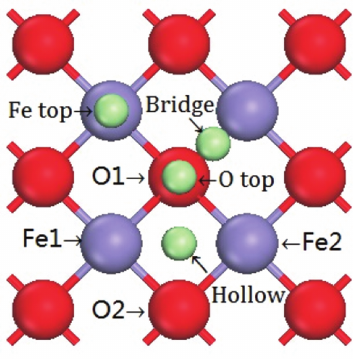
Figure 7: Different adsorption sites of Cl